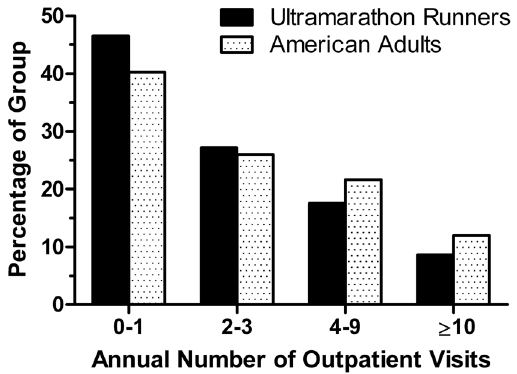
Figure 1. Comparison of annual rates of outpatient medical visits between ultramarathon runners and adult Americans. The percentage of individuals with specified number of annual outpatient medical visits, excluding dental and emergency room visits, are displayed. Adult American data are for those 18 through 64 years of age for the year 2011 as reported by the U.S. Department of Health and Human Services [17]. The Chi-square test showed a significant (p , 0.0001) group